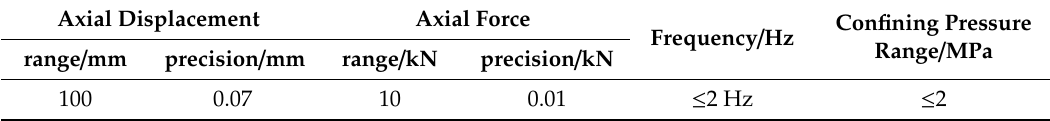
Table 2. The properties of the sand-sawdust mixtures.